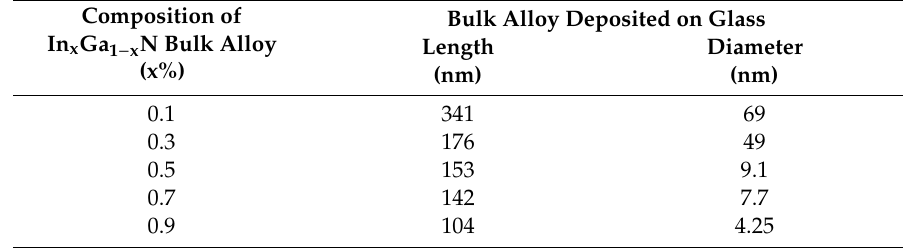
Table 2. Measurements of nanowire diameter and length from FESEM for InxGa1-xN bulk alloys.